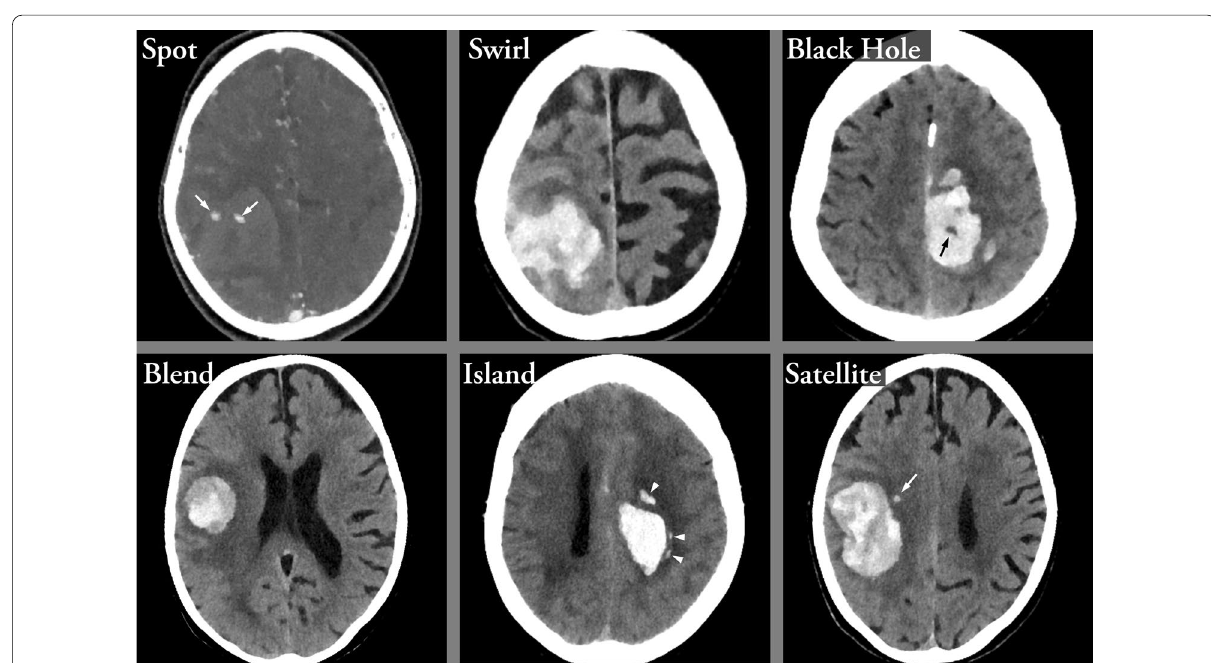
Fig. 2 Imaging Signs. The Spot sign is seen on CTA, the other signs on NCCT. Spot sign —Spot sign is defined as one or more focal enhancements (white arrows) within an acute parenchymal hematoma on CTA, suggestive of active contrast extravasation/active bleeding into the hematoma . Swirl sign —The swirl sign is defined as regions of hypo-attenuation or iso-attenuation within the hyper-attenuated ICH, suggestive of hyperacute bleeding/active bleeding within the acute hematoma. Black hole sign —The black hole sign is defined as well-defined round or oval areas (black arrow) of hypoattenuation enclosed within the hyperattenuating hematoma, without any connection with the adjacent brain parenchyma. Blend sign —The blend sign is defined as regions of mixed hyper-attenuated and hypo-attenuated areas with identifiable boundaries located within the hemorrhage. Island sign —The island sign is defined as: (1) three or more scattered small oval or round hematomas separated from the main hematoma (white arrowheads), or (2) four or more small bubble-like or sprout-like hematomas, some or all of which may be connected with the main hematoma. Satellite sign —The satellite sign is defined as any small hemorrhage (white arrow) with an isolating distance of 1–20 mm from the main